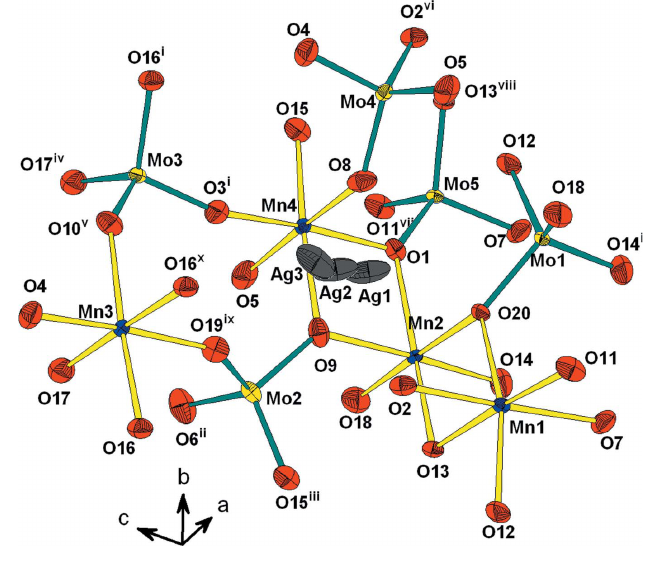
Figure 1 Repre´sentation de l’unite´ asyme´trique dans AgMn II 3 (Mn III 0,26 Al 0,74